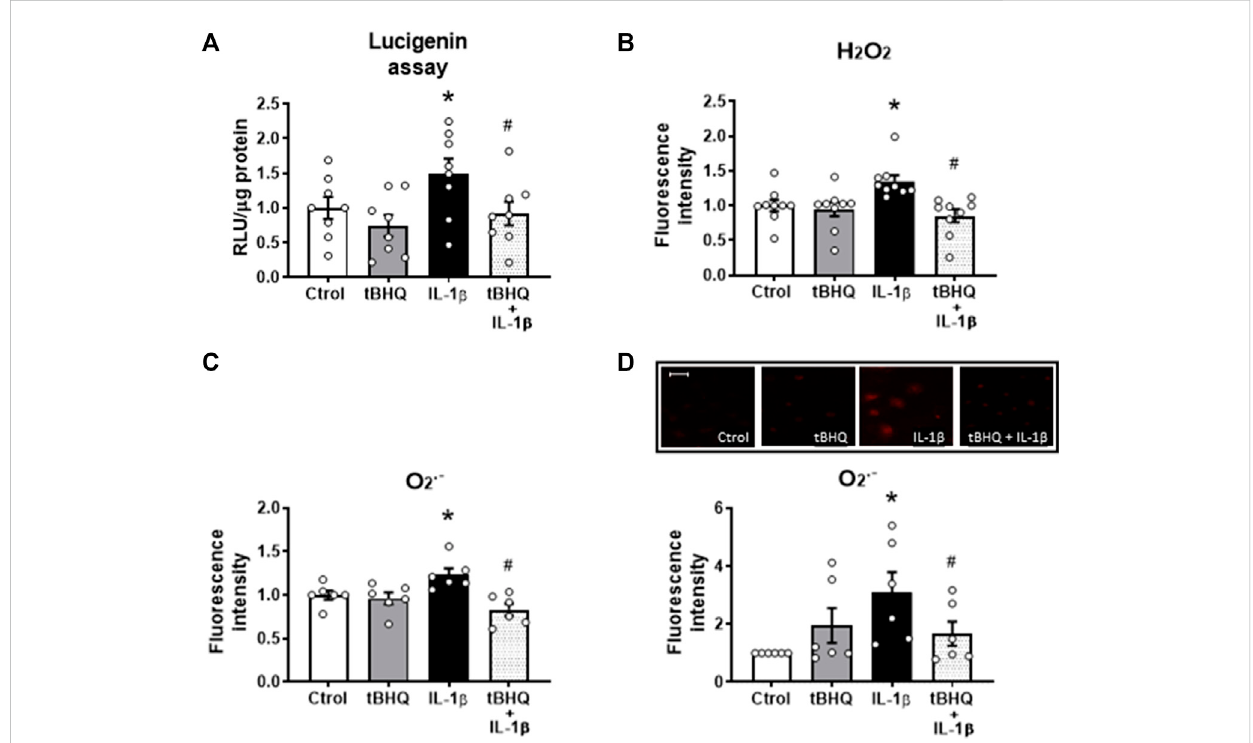
FIGURE 5 Modulation by Nrf2 activation of the IL-1 β -induced effects on oxidative stress. Effect of tert-butylhydroquinone (tBHQ, 20 μ M, 24 h), Interleukin-1 β (IL-1 β ,10 ng/mL,1 h)andtBHQ+IL-1 β onNAPDHoxidaseactivity (A) ,hydrogenperoxide[H 2 O 2 , (B) ]andsuperoxideanion(O 2 .- )productionevaluatedby fl ow cytometry (C) and by fl uorescence microscopy (D) in vascular smooth muscle cells; representative fl uorescent photomicrographs are also shown; images were captured with a fl uorescence microscope; bar scale represents 100 μ m. * p < 0.05 vs. control; # p < 0.05 vs. IL-1 β by Student ’ s t -test ( n = 6 –